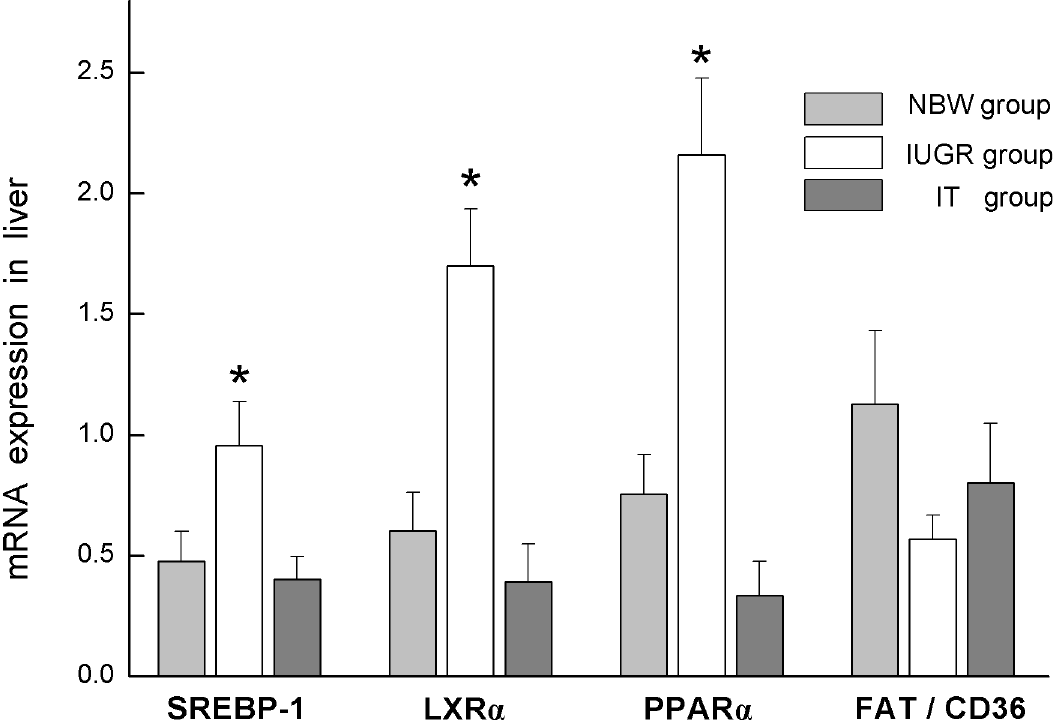
Fig 2. mRNA expression for SREBP-1, LXR α , PPAR α , and FAT/CD36 was normalized using GAPDH as the control. Data are expressed as mean ± SEM, n = 6. SEM, standard error of mean. * indicates a significant difference from control group ( P < 0.05). NBW, piglets with normal birth weight that were fed with basic milk diets; IUGR: piglets with intrauterine growth retardation that were fed with basic milk diets; IT, piglets with intrauterine growth retardation that were fed with diets supplemented with 0.1% tributyrin.